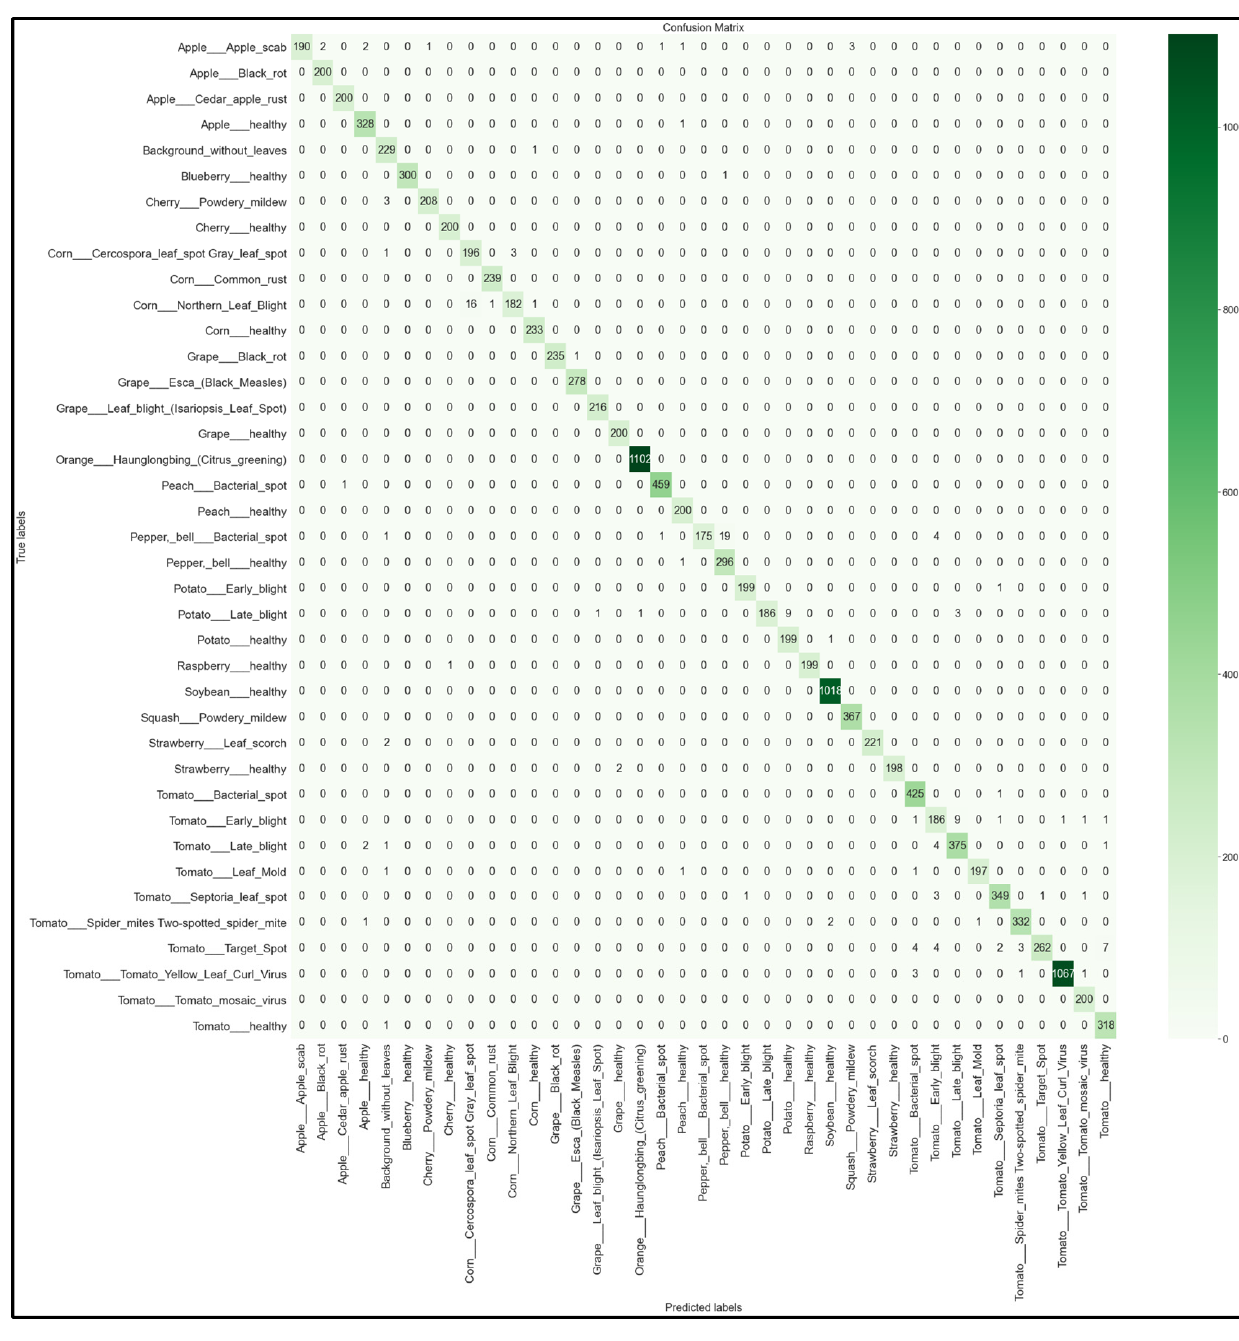
Figure 16. 39 × 39 Confusion matrix for the MobileNetV2 model with transfer learning Scenario 3 and the Proposed hyperparameters.